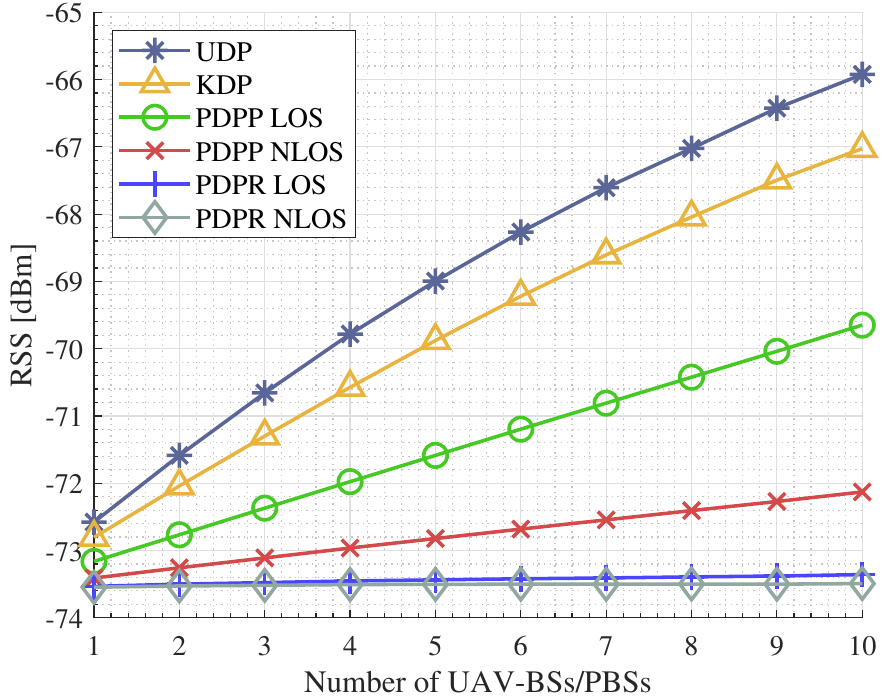
Figure 5. Average downlink RSS for all UEs in the region of interest for different number of UAV-